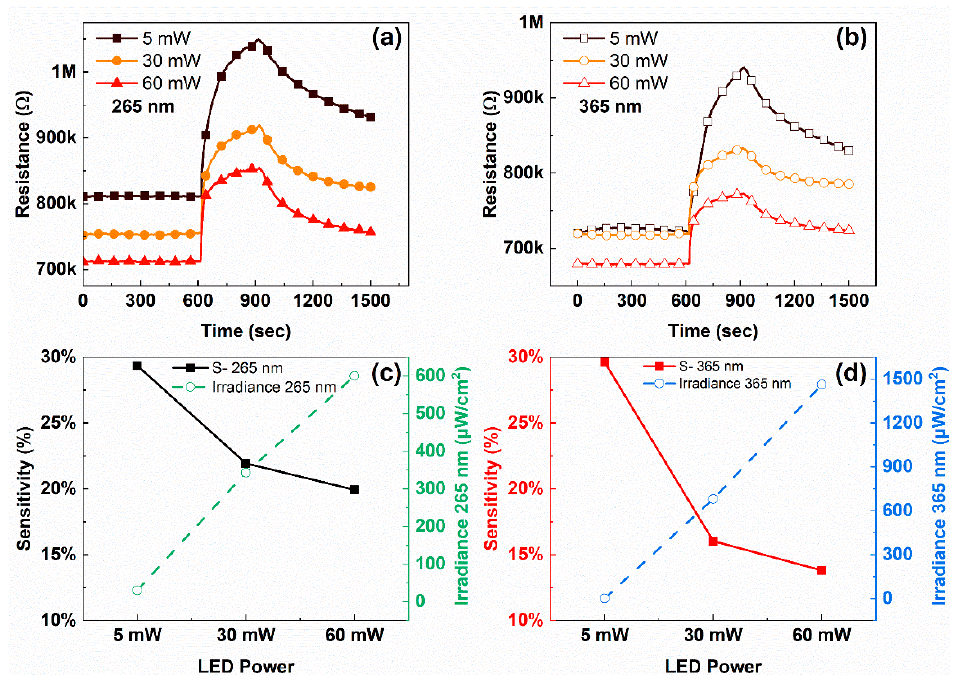
Figure 6. Transient response of 1 ppm NO 2 for Au/In 2 O 3 sensors at fixed 40% RH under ( a ) 265 nm and ( b ) 365 nm irradiance with various LED power. Sensitivity under 265 nm ( c ) and 365 nm ( d ) degrades with increasing LED power.